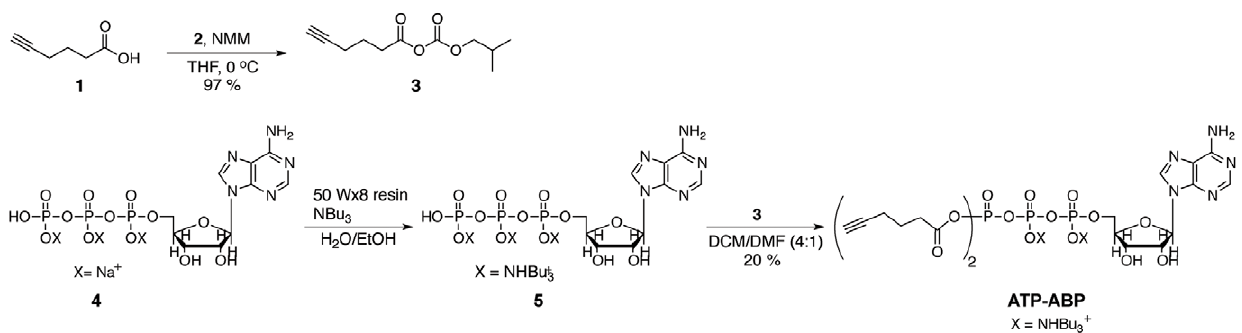
Figure 1. Synthesis of ATP-ABP.